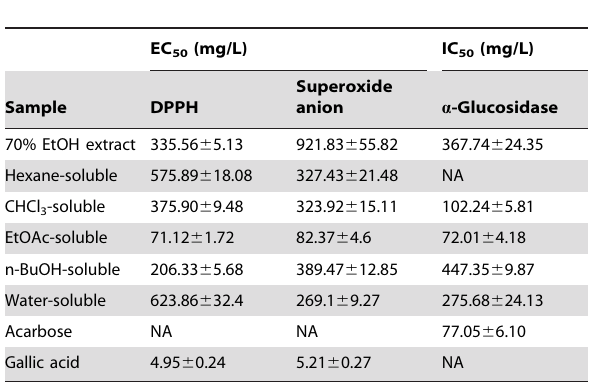
Table 1. DPPH Radical-scavenging, Superoxide anion Radical- scavenging Activities and a -glucosidase Inhibitory Activity of the Extracts from Mulberry Fruit. a, b